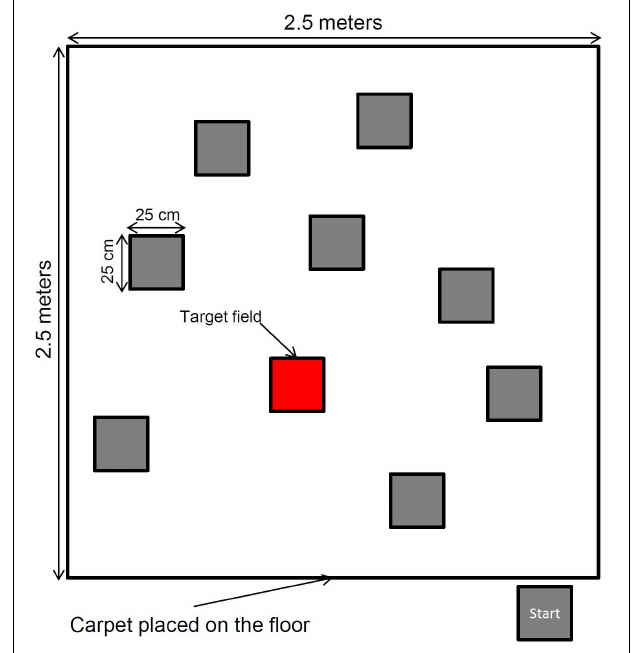
FIGURE 1 | Experimental setup of the spatial memory task, with one illuminated target